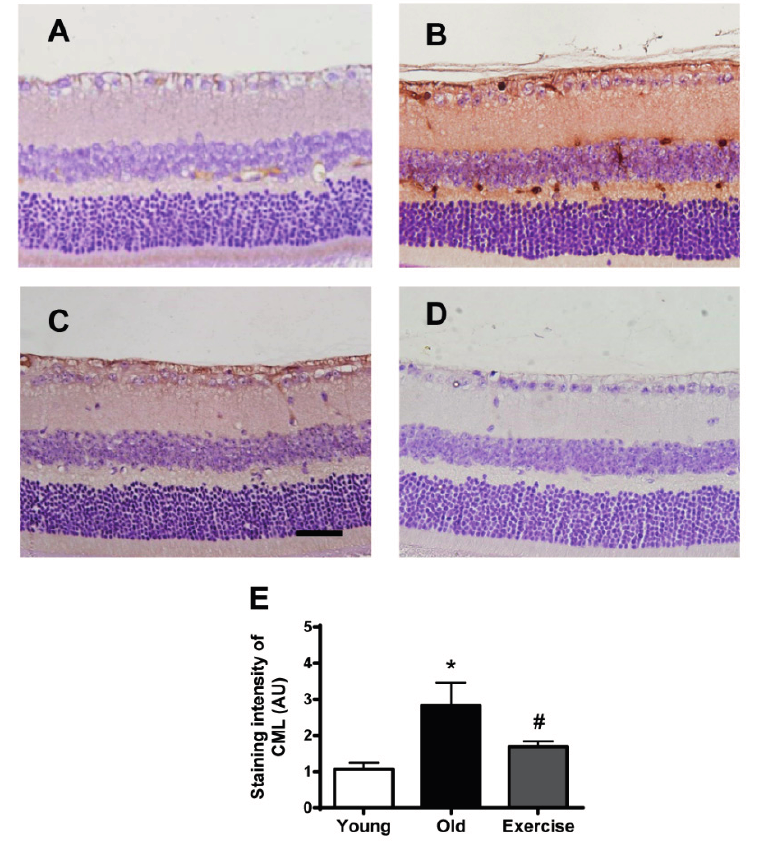
Figure 2. Retinal carboxymethyllysine (CML) formation. Immunohistochemical